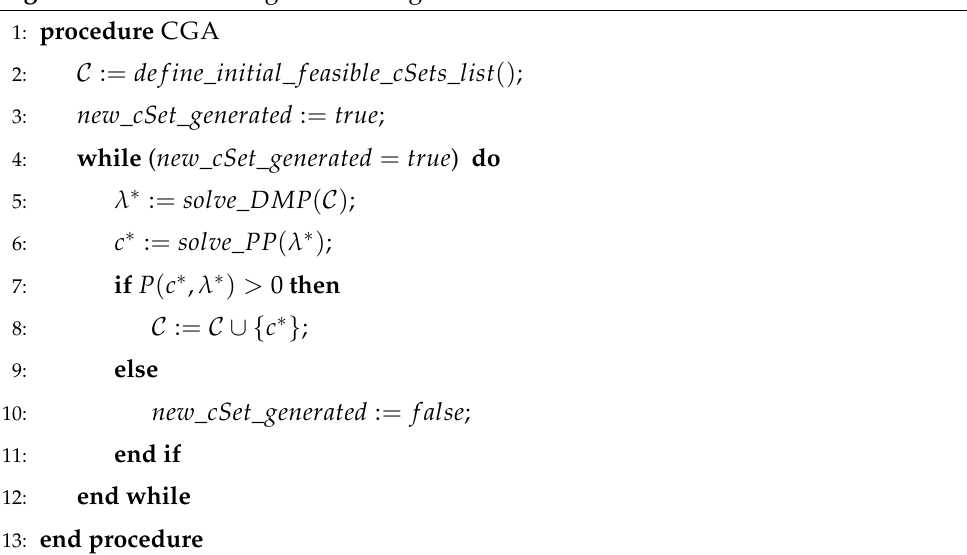
Algorithm 1 CGA: c-set generation